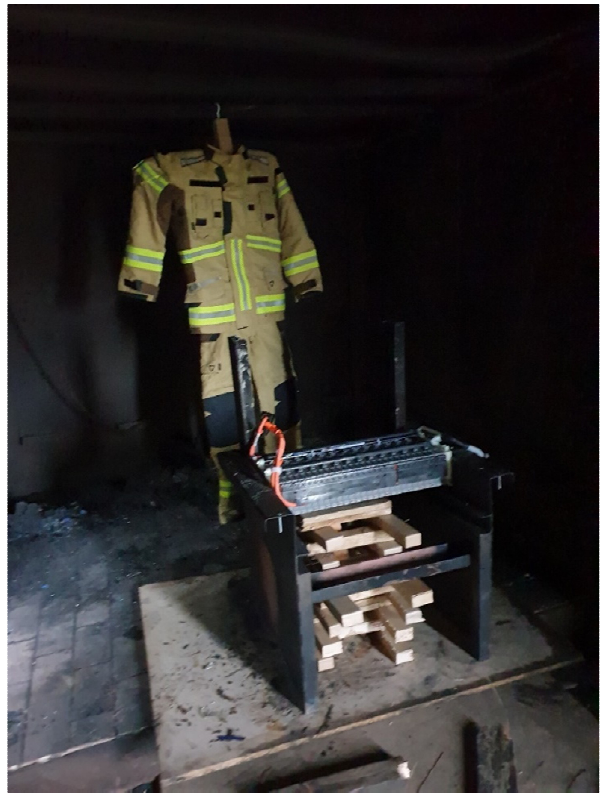
Figure 5. Scenario Test 3 with a car battery in a closed space.